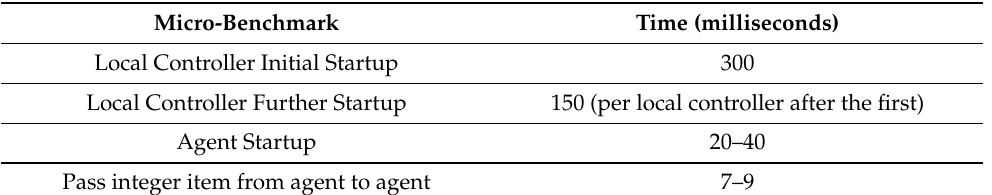
Table 1. Results from